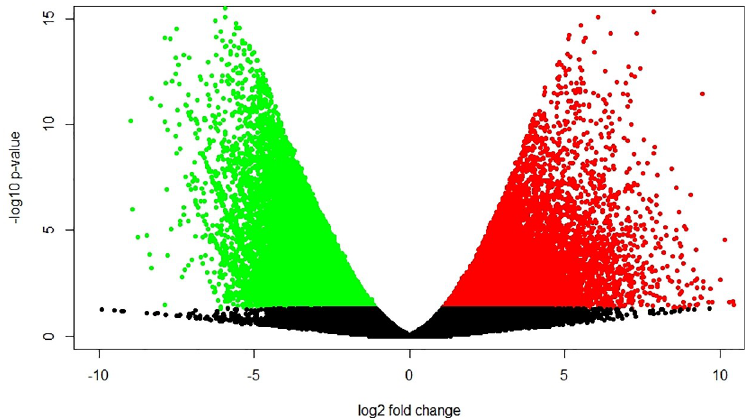
Fig 5. Volcano plot showing differentially expressed genes. 15,234 significantly differentially expressed genes were identified between the leaves and apical meristems. The red dots represent significantly up-regulated genes and green dots represent significantly downregulated genes with a P-value <